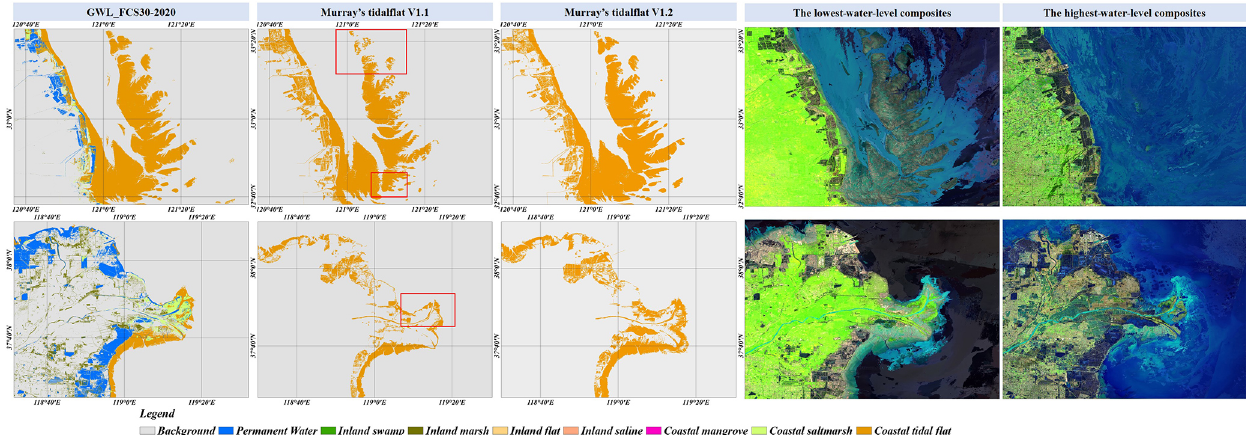
Figure 15. The comparisons between the tidal flat of GWL_FCS30 in 2020, Murray’s tidal flat V1.1 in 2016 (Murray et al., 2019) and Murray’s tidal flat V1.2 in 2019 (Murray et al., 2022) for two local regions. In each case, the highest- and lowest-tidal-level composites, composited by SWIR1, NIR and red bands, are illustrated. Table 6. The accuracy metrics of NLCD, NWI and GWL_FCS30 using 1835 validation points over the contiguous United